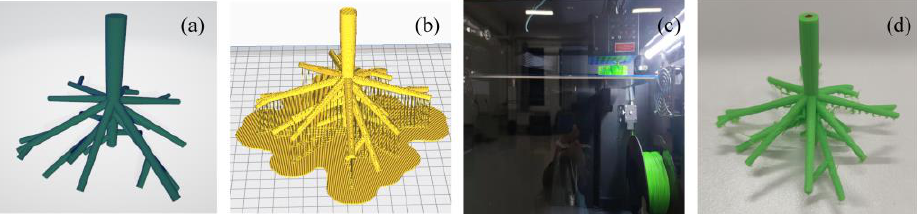
Figure 4. Printing process of 3D printer. ( a ) modeling, ( b ) slice, ( c ) print, ( d ) root system.